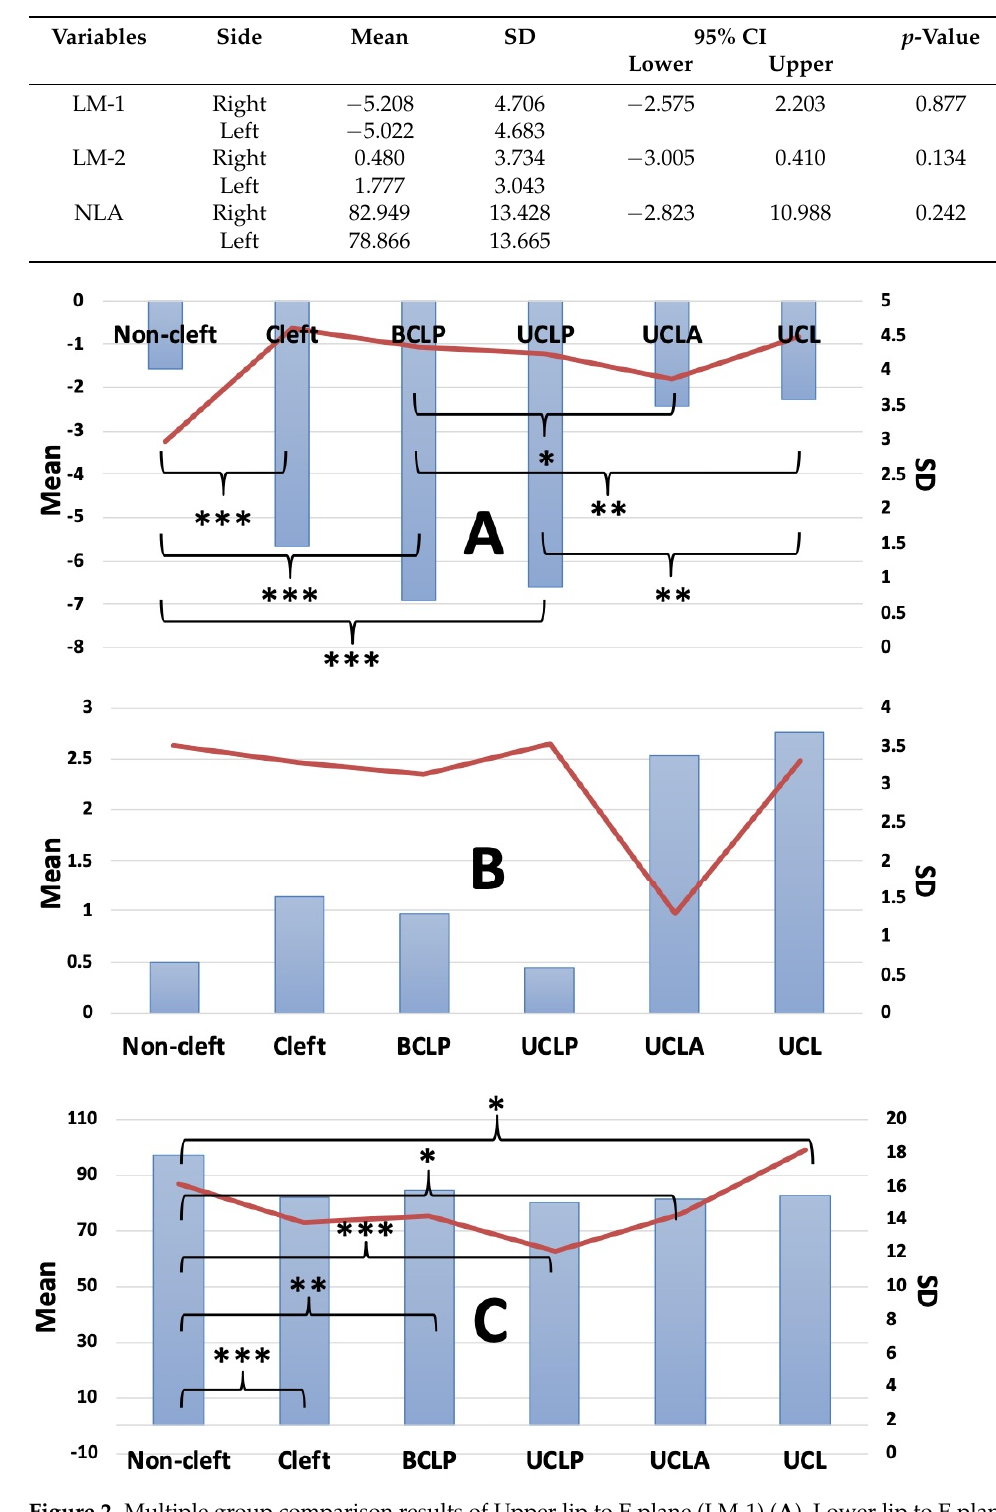
Figure 2. Multiple group comparison results of Upper lip to E plane (LM-1) ( A ), Lower lip to E plane (LM-2) ( B ), and Nasolabial angle (NLA) ( C ) in non-cleft, unilateral cleft lip and palate (UCLP), bilateral cleft lip and palate (BCLP), unilateral cleft lip and alveolus (UCLA), and unilateral cleft lip (UCL) individuals. ( p < 0.05 = *, p < 0.01 = **, p < 0.001 =